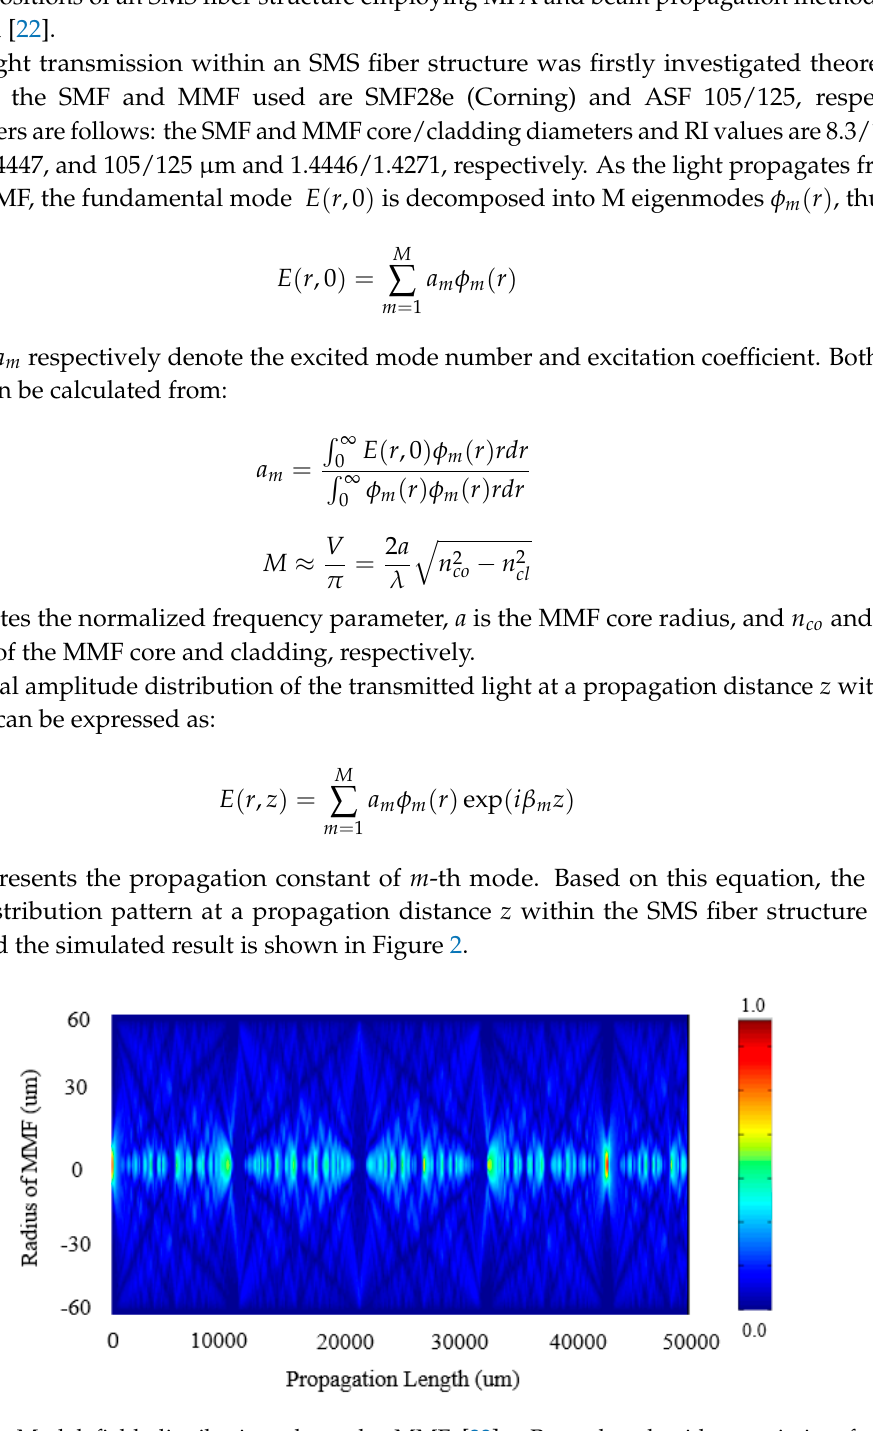
Figure 2. Modal field distribution along the MMF [22]. Reproduced with permission from Xianfan Wang, Elfed Lewis, Pengfei Wang, Investigation of the Self-Imaging Position of a Singlemode-Multimode-Singlemode Optical Fiber Structure; published by Wiley Online Library, 2017.